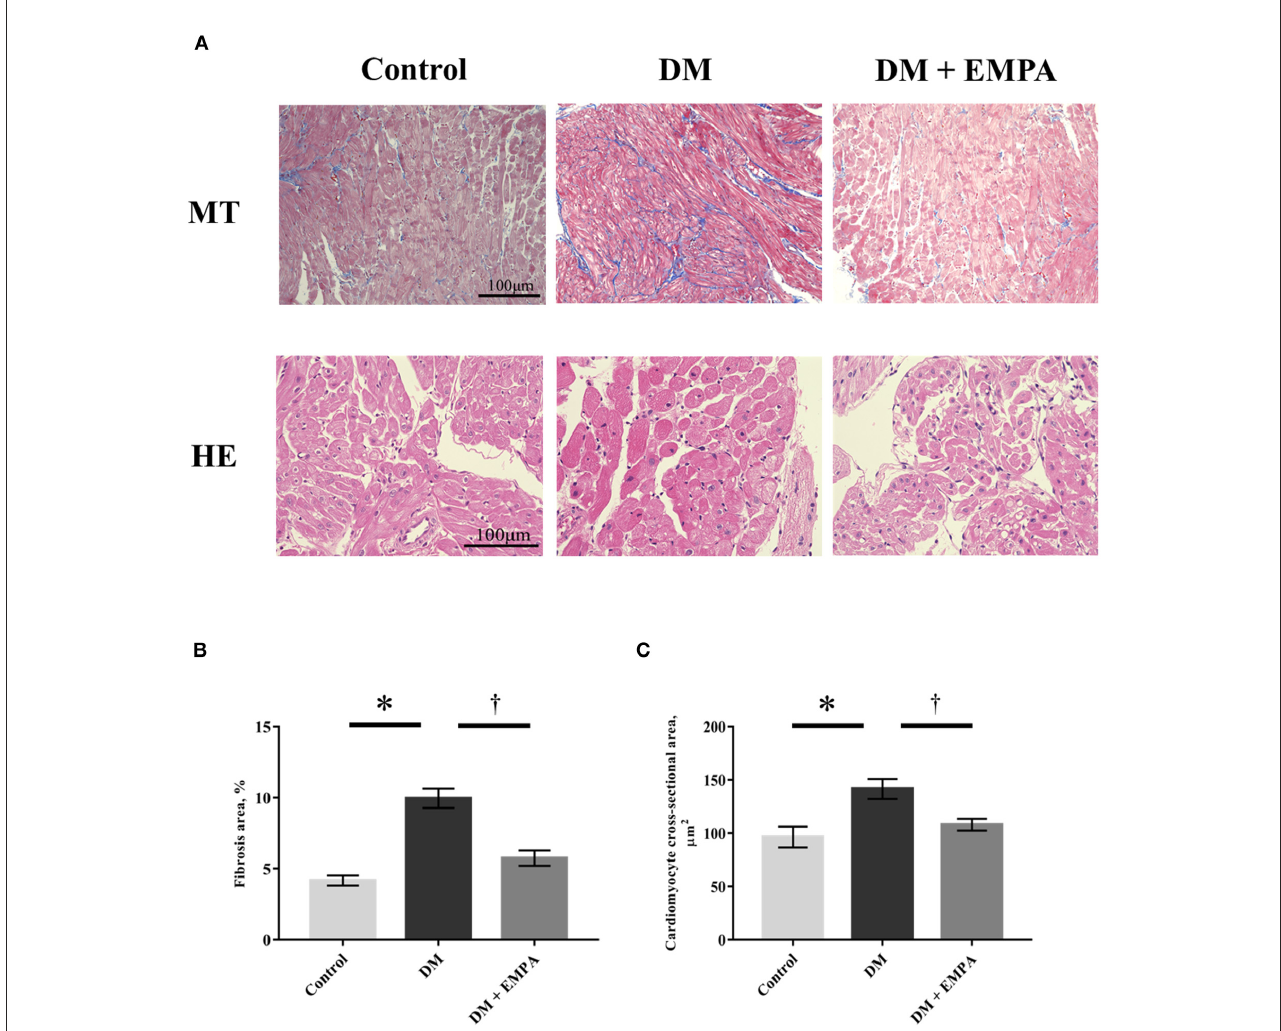
FIGURE2 Histological study. (A) Representative images of right atrial tissue stained with Masson’s trichrome (upper panels) and hematoxylin as well as eosin (bottom panels). (B) Area of fibrosis. (C) Cardiomyocyte cross-sectional area. Data are expressed as mean ± SE ( n = 8 per group). * p < 0.05: vs. Control, † p < 0.05: vs. DM (One-way repeated ANOVA with post hoc Tukey’s multiple-comparison test). MT, Masson’s trichrome stain; HE, hematoxylin and eosin stain; DM, diabetes; EMPA,